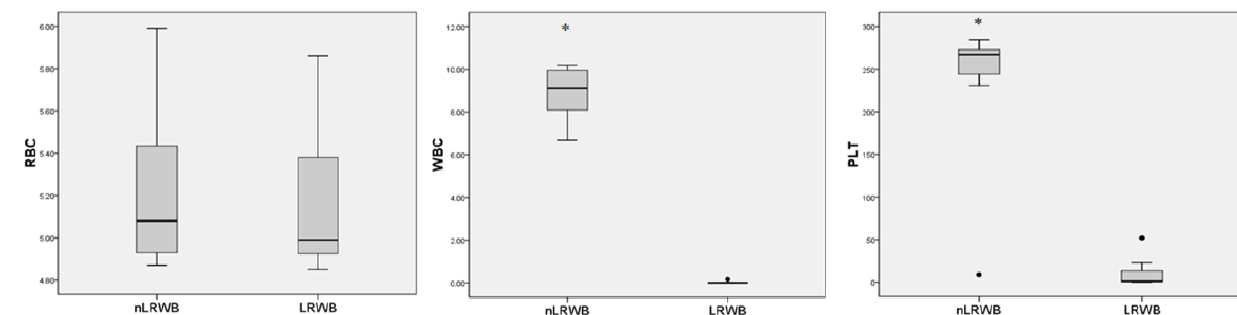
Figure 1. Leukoreduction effectiveness. Box plots (indicating median as lane and interquartile range as box) of RBC( × 10 12 /L), WBC( × 10 9 /L), and PLT( × 10 9 /L) counts before (nLRWB) and after (LRWB) leukoreduction of whole